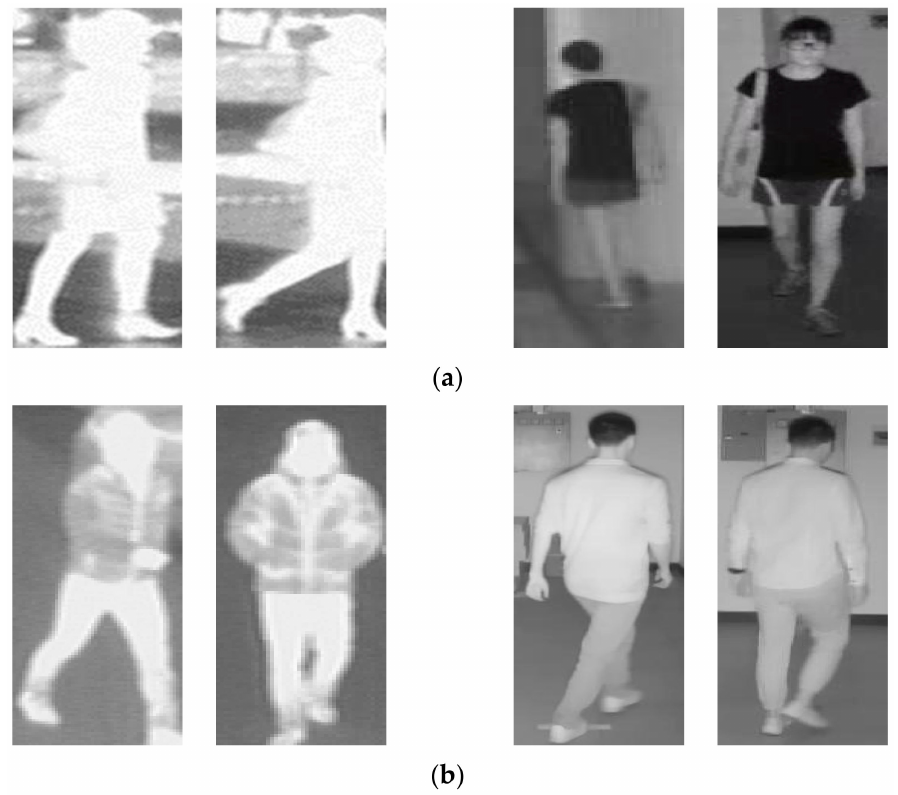
Figure 15. Examples of ( a ) correct acceptance from genuine matching and ( b ) correct rejection from imposter